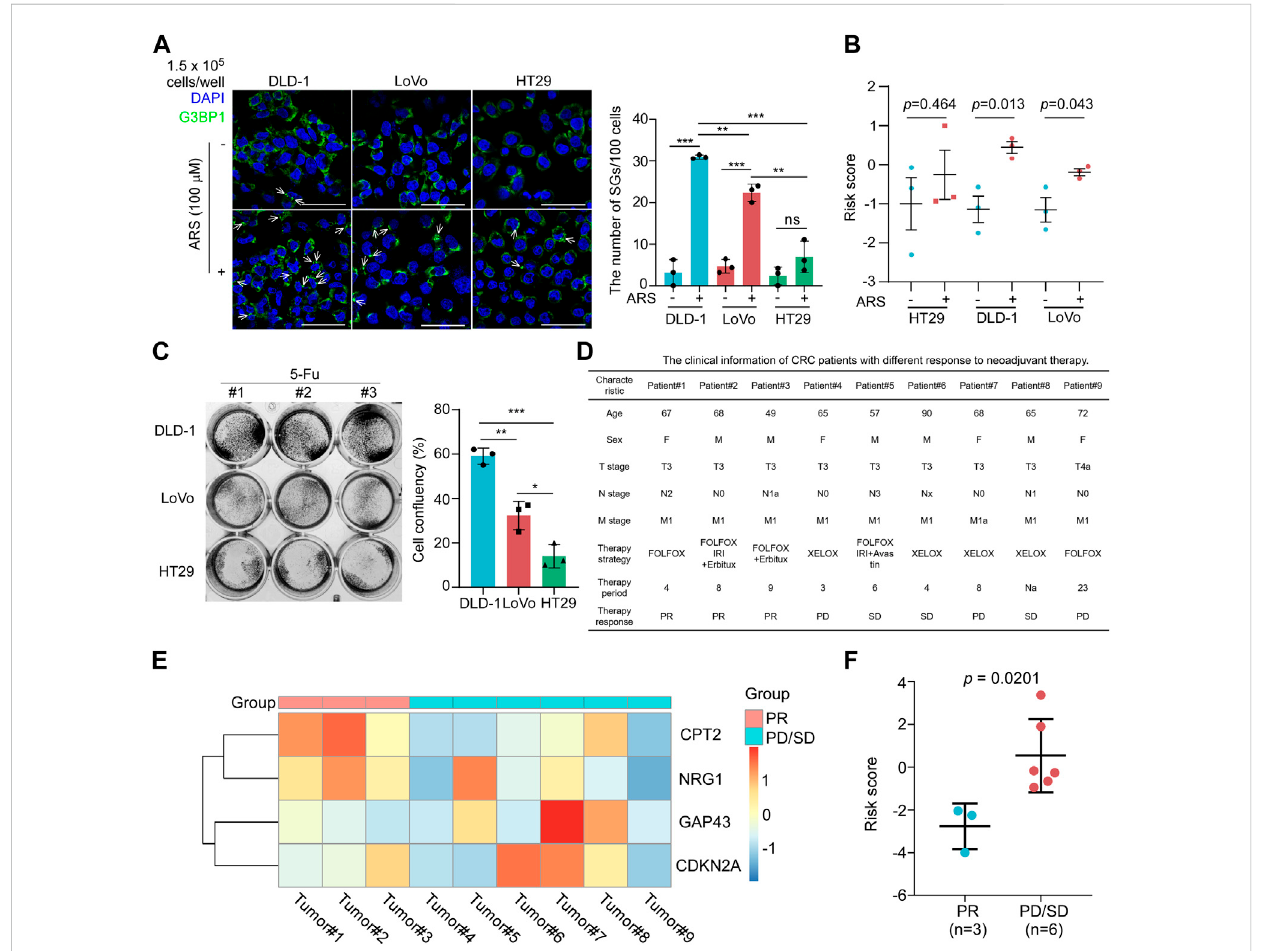
FIGURE 8 The risk score of SGPPGS is associated with chemotherapy response. (A,B) HT29, DLD-1, and LoVo colorectal cancer cells were treated with or without SodiumArsenite(100 μ M)for1 handsubjectedto (A) .Immuno fl uorescenceassayusingantibodyspeci fi cforG3BP1.Thewhitearrowsindicated the SGs as characterized by assembly signaling of G3BP1 in cytoplasm, and qRT-PCR, then the mRNA expression levels of CPT2, NRG1, CDKN2A, and GAP43wereusedtocalculatetheriskscore,and (B) thequantitiveresultsplotwasshown(Scalebar=50 μ m). (C) DLD-1,LoVo,andHT29cellswere treated with 5-Fu (100 μ M) for 24 h, then subjected to crystal violet staining. Unpaired two-tailed Student ’ s t -test was used for comparison between two groups. Data were presented as means ± SD. * p < 0.05; ** p < 0.01; *** p < 0.001. (D) The clinical information of CRC patients with different response to neoadjuvant therapy. (E,F) The primary tumor samples from metastatic colorectal cancer patients as described in (D) were subjected to qRT-PCR analyses.ThemRNAexpressionlevelsofCPT2,NRG1,CDKN2A,andGAP43wereusedtogeneratetheheatmap (E) andwereusedto (F)